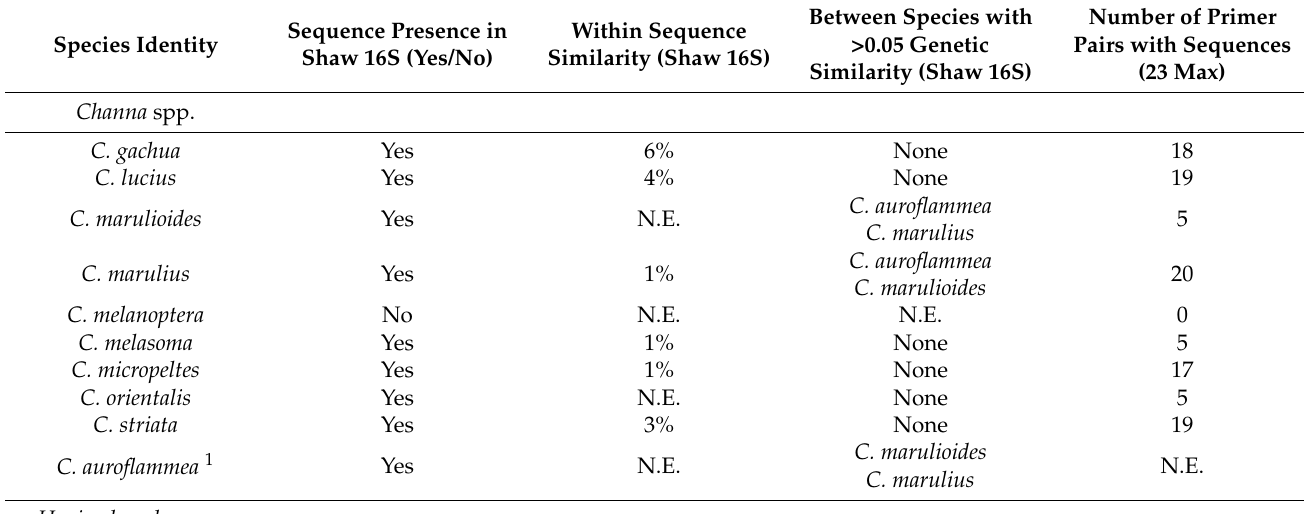
Table 2. Evaluation of species specificity (N.E. = Not Estimable).